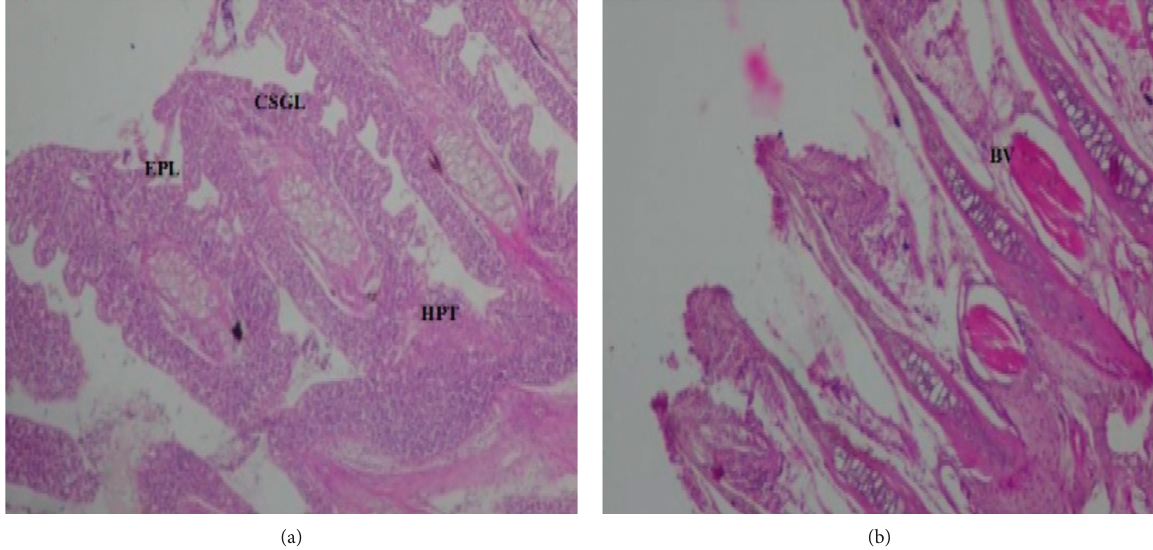
Figure 12: (a) Histological section of gill exposed to nano-SiO/Al 2 O 3 (1: 2) showing curved secondary gill lamella (CSGL), epithelial lifting (EPL), and hypertrophy (HPT) (H&E stains, × 400). (b) Histological section of gill exposed to nano-SiO/Al 2 O 3 /CuO showing total de- struction of gill architecture. Blood vessel is seen (H&E stains, ×